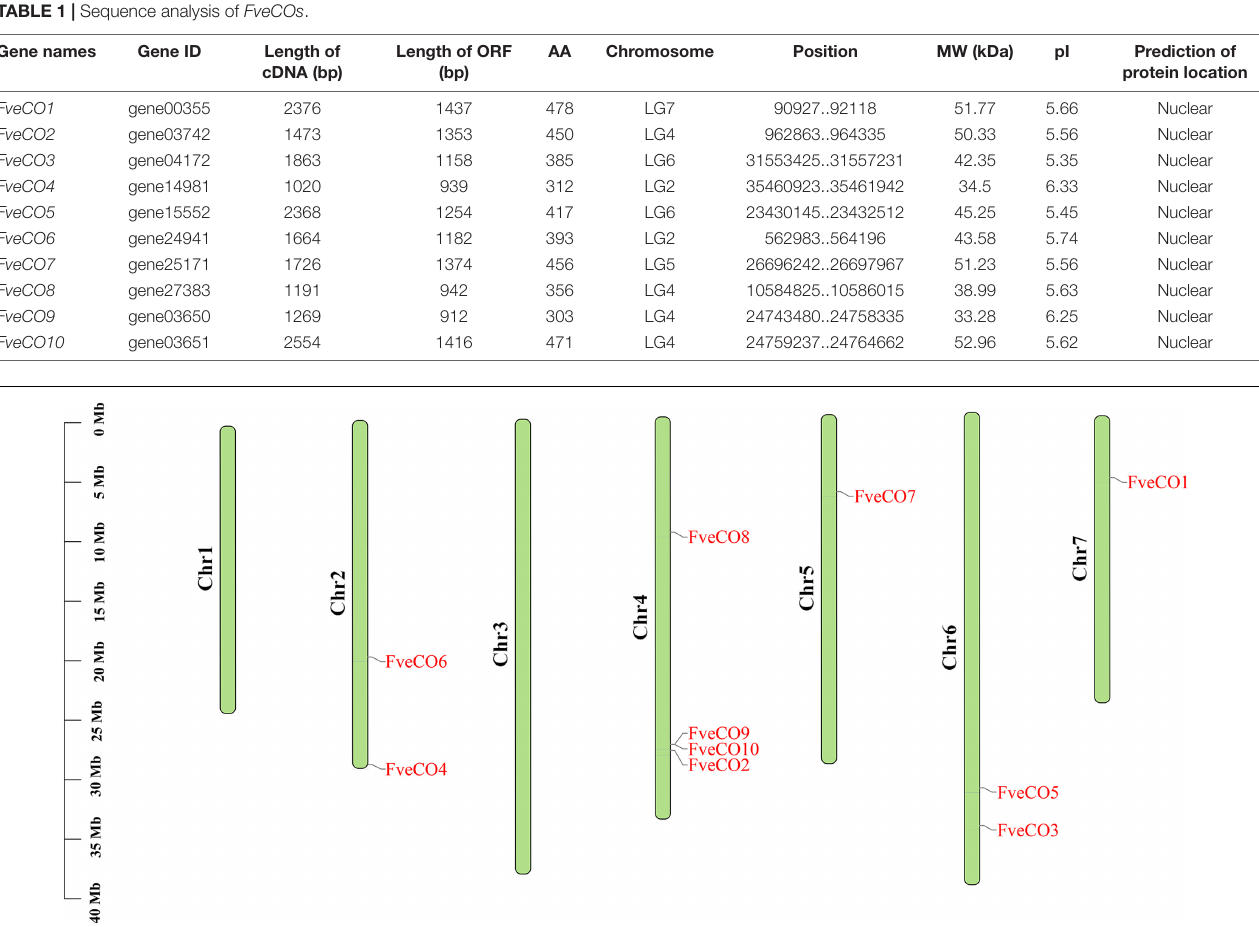
FIGURE 1 | Chromosome localization map of FveCOs . The light green vertical bars with various lengths represent woodland strawberry chromosomes. Short black vertical lines indicate the position of each FveCOs.